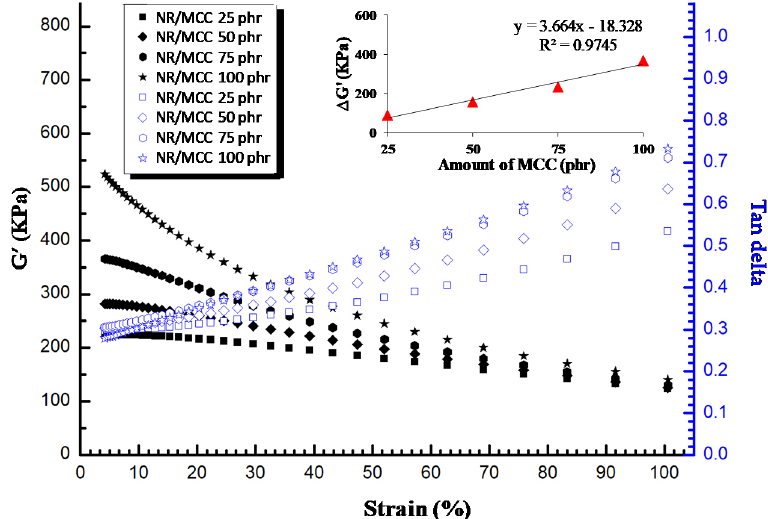
Figure 9. Payne effect ( left ; solid) and damping factor (tan delta, right ; open) as a function of strain for NR with MCC particles at 25–100 phr.